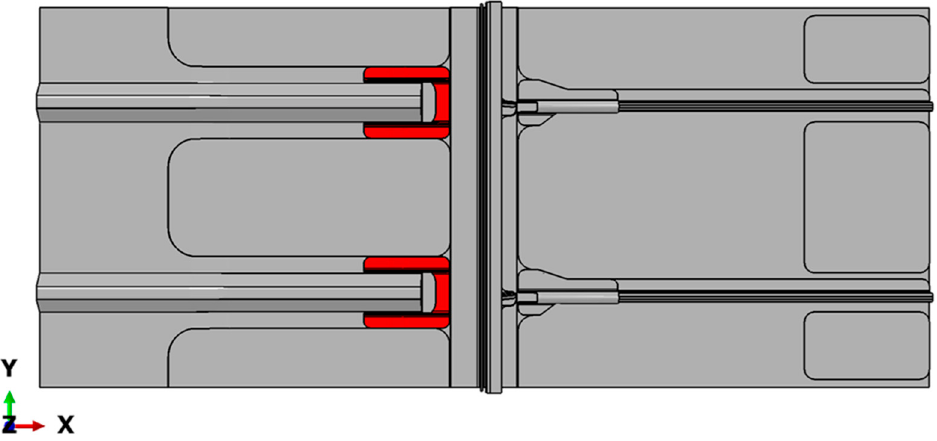
Figure 24. Omega stringer joint (in red).